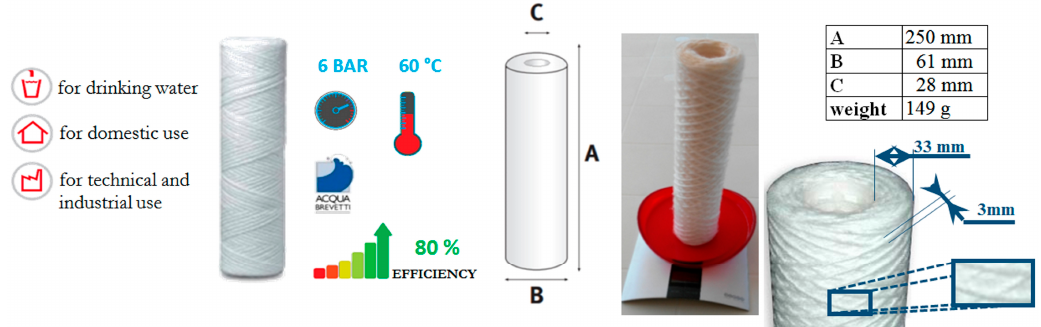
Figure 1. Adopted wire-wound filter cartridge.